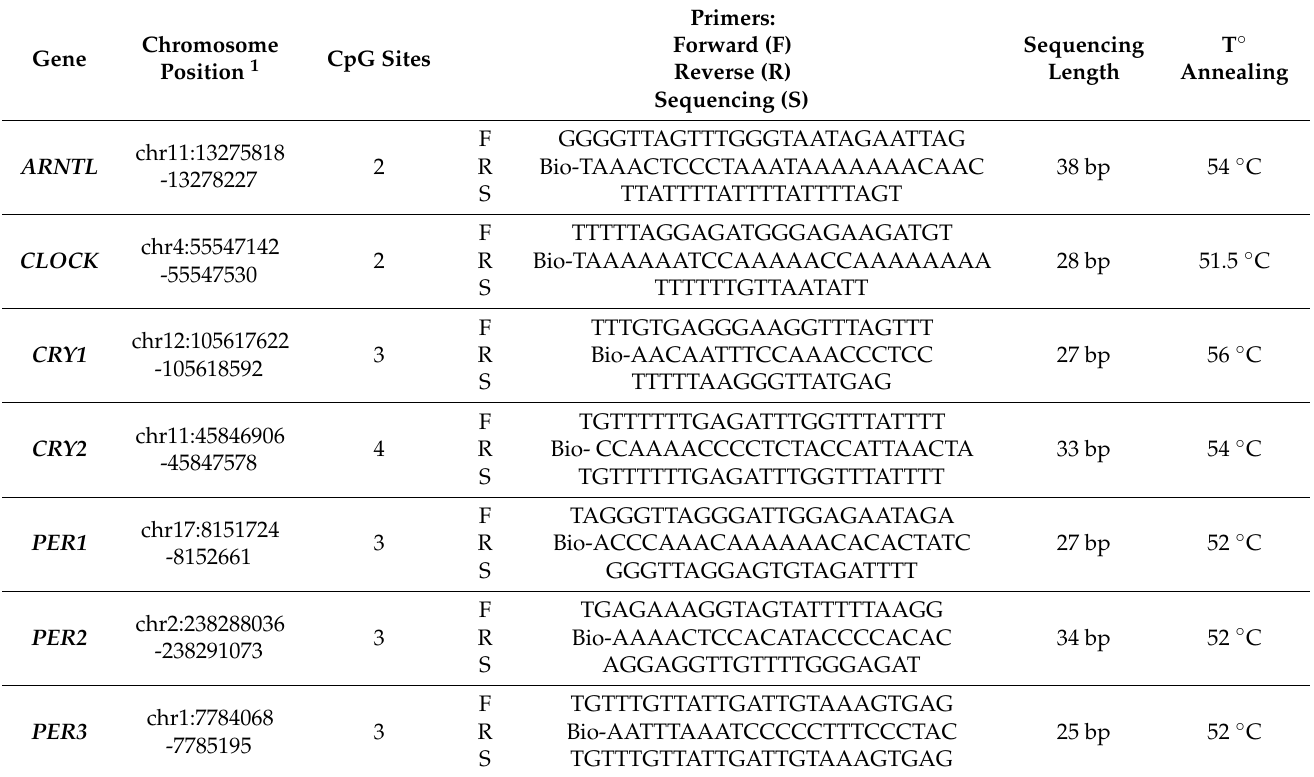
Table 1. Pyrosequencing assay